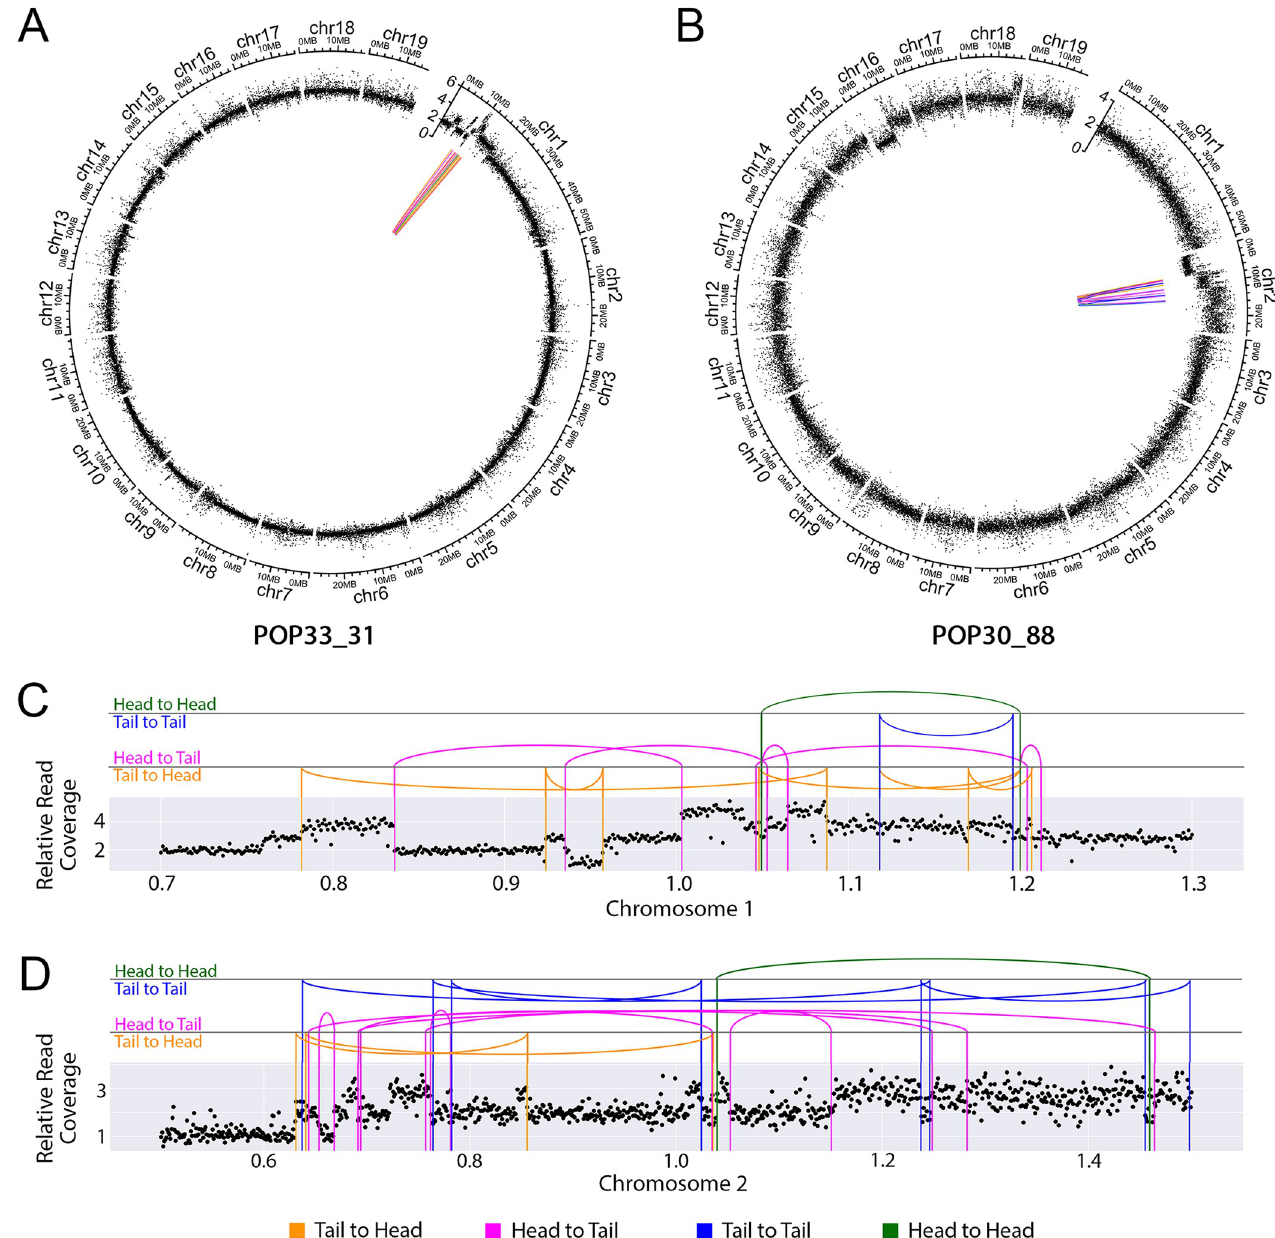
Fig 5. Distribution of the genomic location of the validated DNA junctions. (A-B) DNA junctions in the two shattered lines (POP33_31 (A) and POP30_88 (B)). The outermost layer displays each chromosome. The next layer displays relative reads coverage, averaged over 10kb non-overlapping bins. In the center, colored lines connect the original genomic locations of each pair of sequences found in novel DNA junctions. (C-D) Close-up view of DNA junctions distribution on the shattered regions of chromosome 1 in POP33_31 (C) and chromosome 2 in POP30_88 (D). The scatter plots show average relative read coverage per 10kb bins, and the colored vertical lines represent exact breakpoints. The arc connecting two vertical lines illustrate the novel junctions connecting vertical lines that represent the breakpoints. All panels: Magenta and orange lines represent sequences that connect in the same direction (Head to Tail in magenta and Tail to Head in orange). Blue and green lines represent sequences that connect in opposite directions (Tail to Tail in blue and Head to Head in